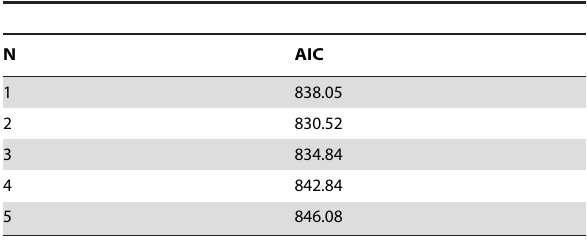
Table 1. The AIC score for each N -gram model is displayed in second